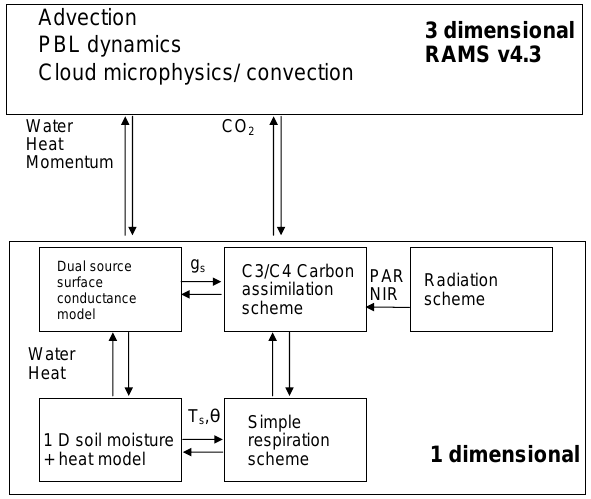
Fig. 1. Schematic of the coupling between RAMS and SWAPS- C. The main interactions between submodels is also given together with the variables with g s – surface conductance, T s – surface tem- perature, θ – soil moisture, PAR – photosynthetically active radia- tion, NIR – near infrared